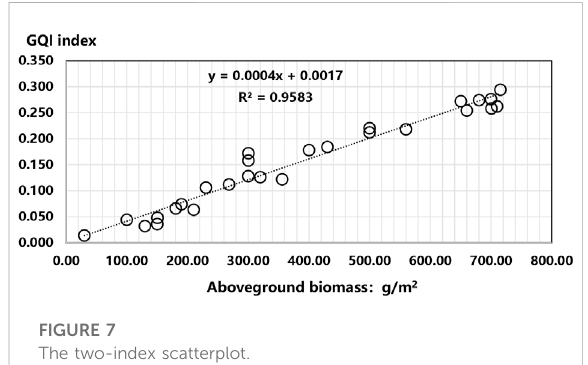
FIGURE 7 The two-index